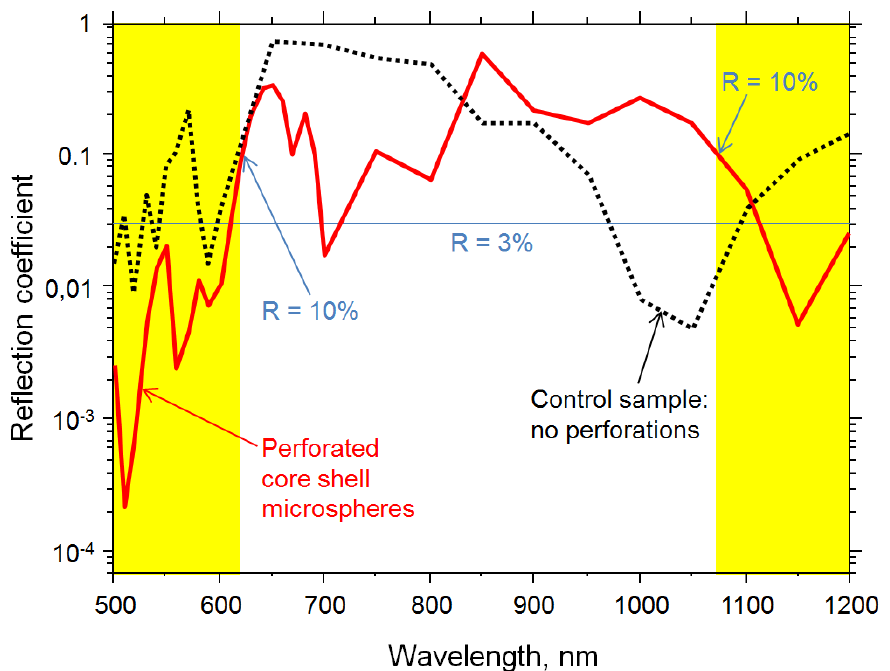
Figure 11. Solid red line: spectral reflection coefficient of a square planar array of golden hollow spheres with a 600 nm diameter, a wall thickness of 20 nm, perforated by holes with a 160 nm diameter and with a distance between two neighboring spheres equal to 200 nm. Dotted black line: the same dependence for a control sample, having the identical geometry and materials, but without perforations. Yellow fields at short wavelengths (500 nm—620 nm) and at long wavelengths (1070 nm—1200 nm) denote the spectral ranges where the reflection coefficient does not exceed 10%, while the blue horizontal line is the 3% limit of the reflection coefficient. The superior antireflective properties of perforated core shells at shorter wavelengths are clearly observable.